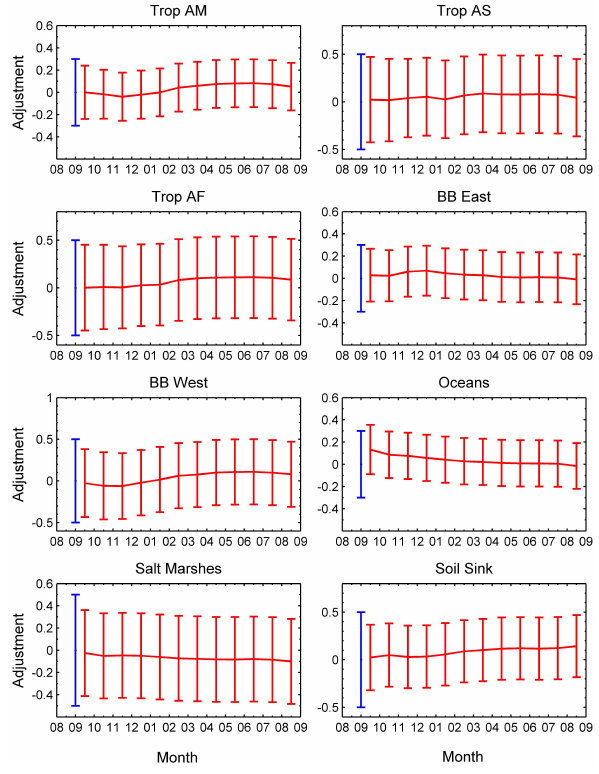
Fig. 5. The recursive estimation of CH 3 Cl surface fluxes for a single month (September 2002) obtained with the use of monthly observa- tions from September 2002 to August 2003 (horizontal axis). The vertical axis corresponds to the dimensionless adjustment from the reference value (unity). The blue line shows the a priori error bar (either ± 0.3 or ± 0.5) for the September 2002 surface flux. The fi- nal optimized results are taken as the values at the last step at which time the inversion has